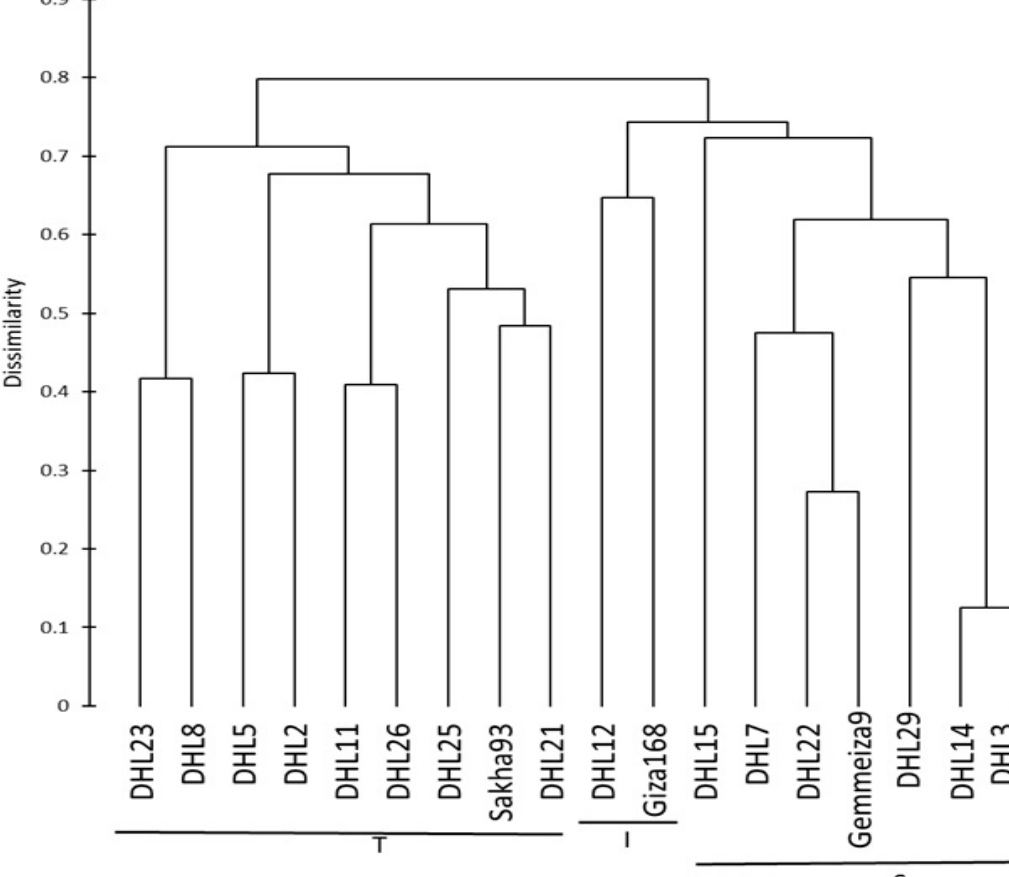
Figure 2. Dendrogram showing clustering of 18 wheat genotypes based on the Jaccard dissimilarity coefficient based on the allelic data of 23 simple sequence repeat (SSR) markers linked to salt-tolerant genes. DHL: doubled haploid line, T: tolerant, I: intermediate, and S: sensitive.